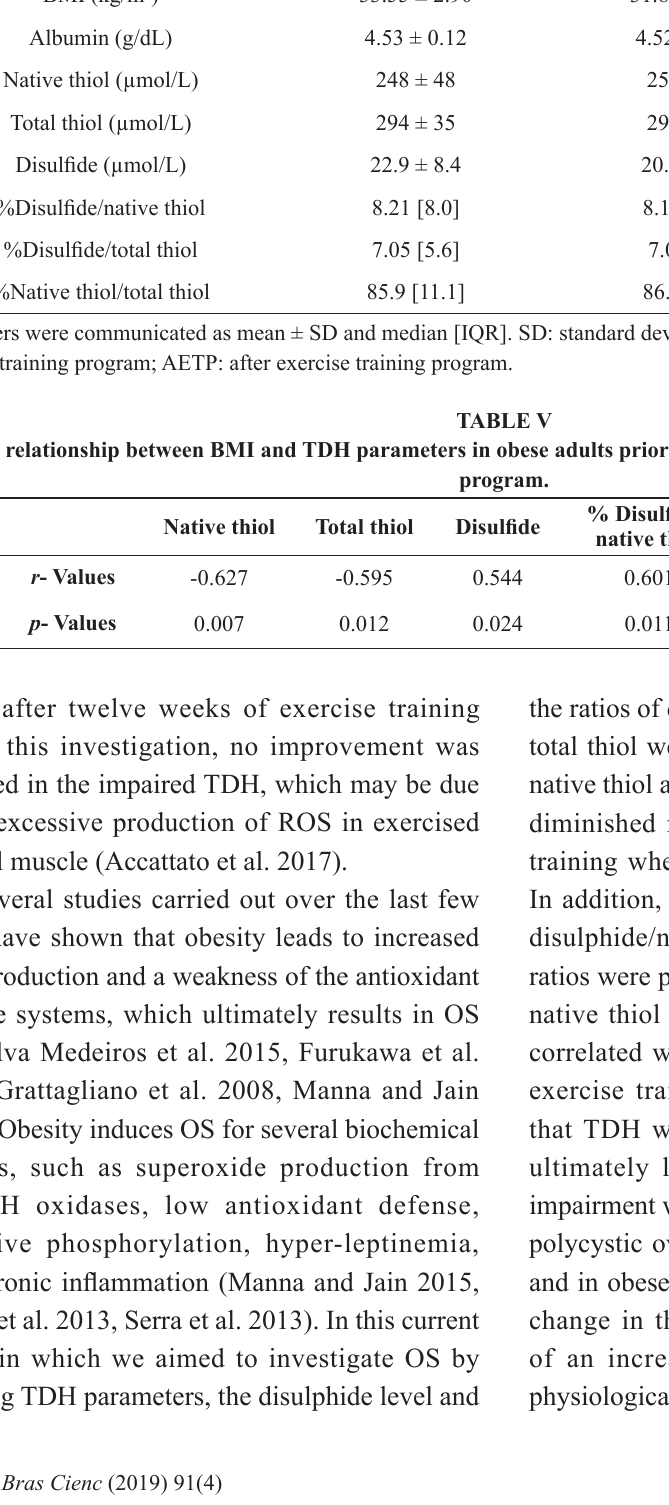
tHe eFFeCt OF NeWlY INItIAteD eXeRCISe tRAINING